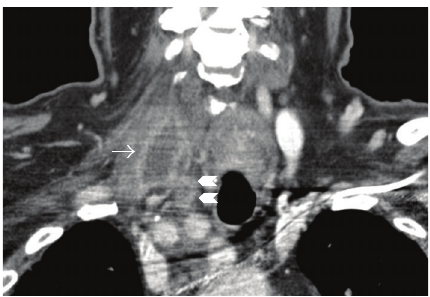
Figure 3: Coronal CT demonstrating a rim-enhancing fluid collec- tion in the right neck (arrow) and inflammatory changes tracking into the mediastinum